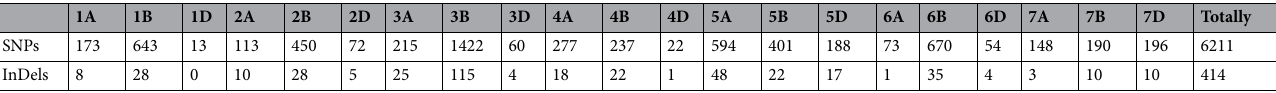
Table 1. The number of SNPs and InDels between WT and st1 found on each of the 21 wheat chromosomes.